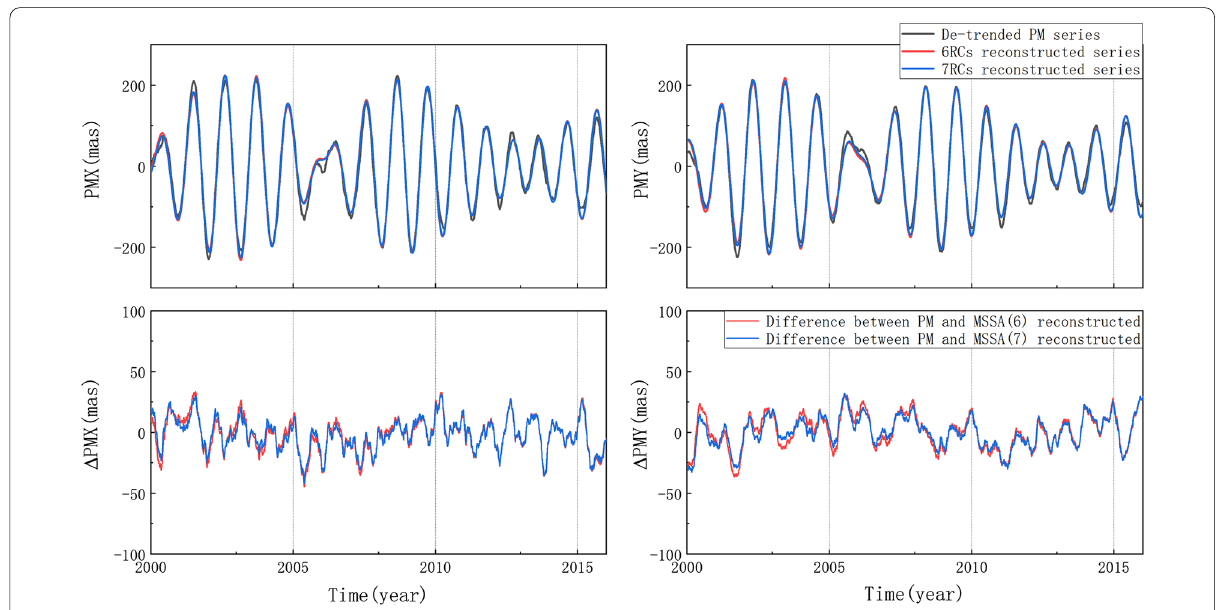
Fig. 7 Reconstructed PM time series